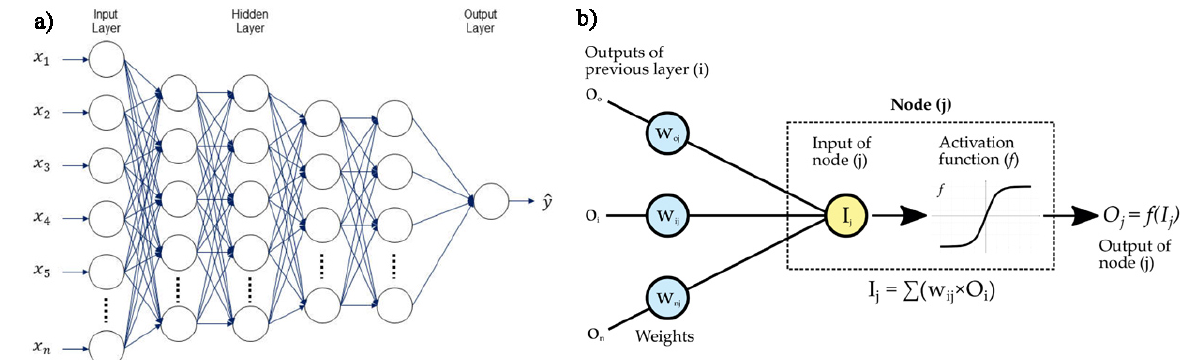
Figure 15. ( a ) Example scheme of a deep neural networks, reprinted from Ref. [103] under the terms of the CC-BY license; ( b ) operating principle of a single